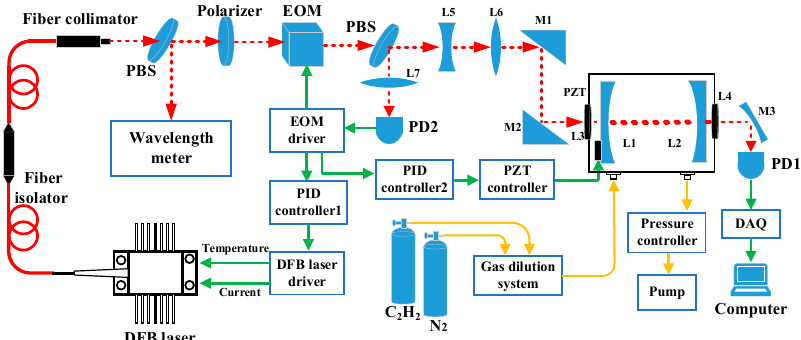
Figure 3. Structure of the frequency-locked cavity-enhanced absorption spectroscopy (CEAS)-based C 2 H 2 detection system. The red lines represent optical pathways, the green lines represent electrical signal pathways, and the yellow lines are gas flow pathways. PD, photodiode; PBS, polarization beam splitter; DFB, distributed feedback; EOM, electro-optic modulator; PID, proportional–integral–derivative; PZT, piezoelectric transducer; DAQ, data acquisition; L1–7, lens 1-7; M1–3, mirror 1-3.